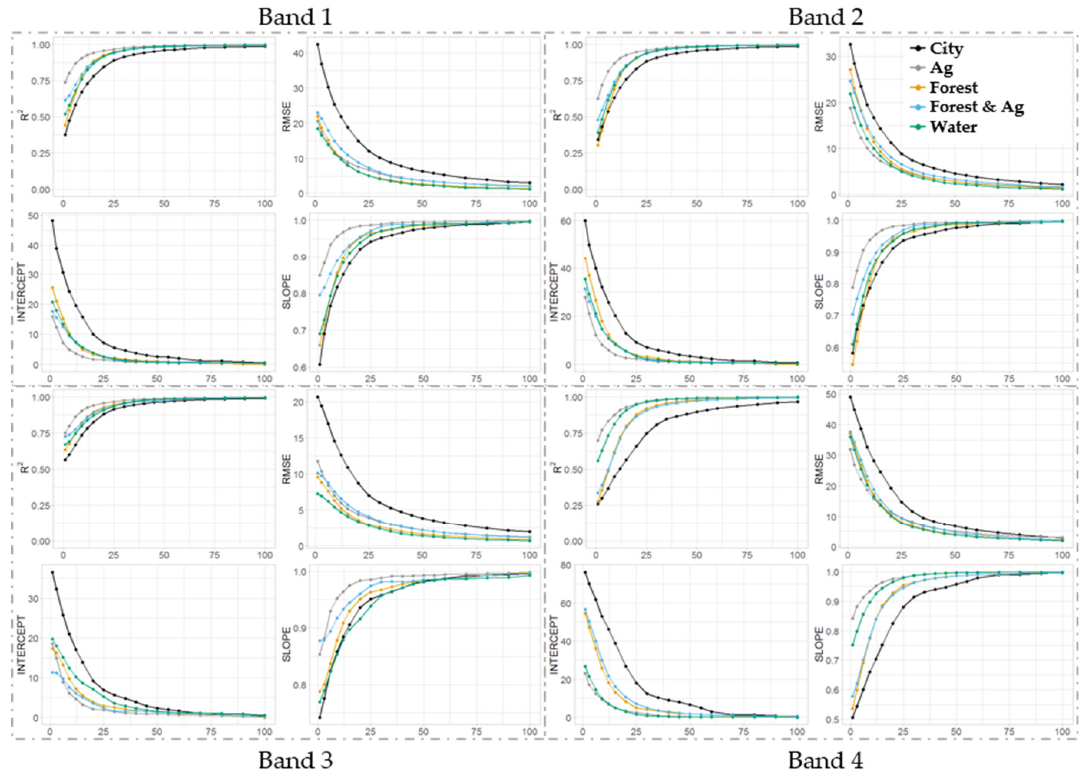
Figure A2. Stage I NAIP image regression statistics for varying sample unit sizes and spectral bands given average raster and GPS registration errors of 6 and 7 cells respectively.